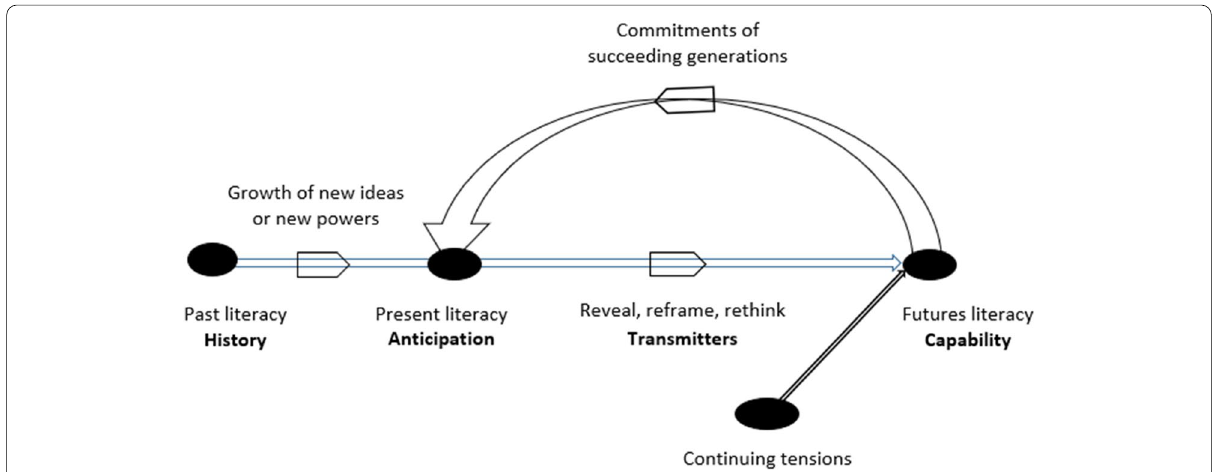
Fig. 2 The functional form of historicist